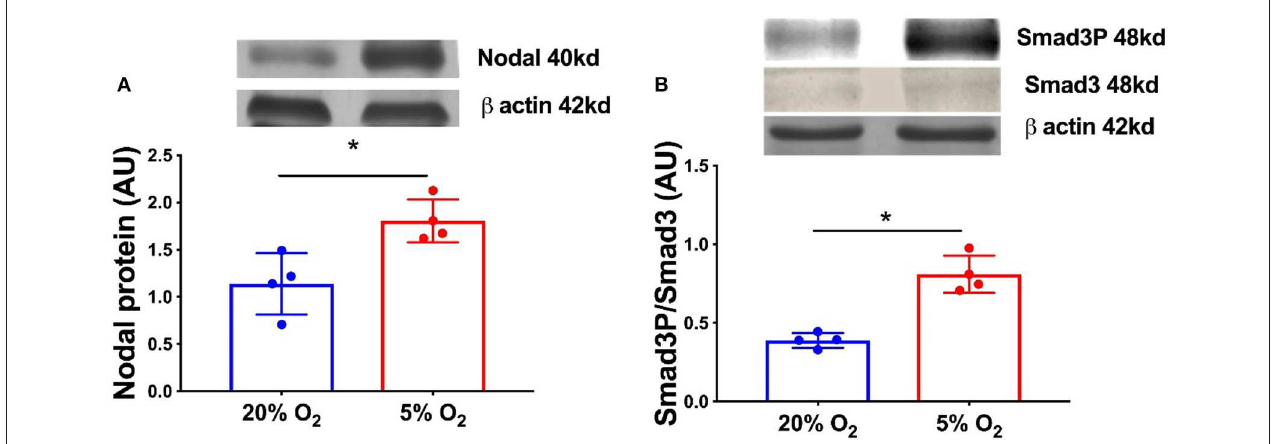
FIGURE 3 | Nodal signaling in mid CL explants cultured in vitro under hypoxia. Effect of hypoxia on (A) Nodal protein expression and (B) phosphorylation of Smad3 in mid CL explants cultured under 20% O 2 or 5% O 2 for 24h ( n = 4). Protein expression determined by western blot, upper panel: representative immunoblot; lower panel: densitometry of protein expression relative to β -actin expression. Values are expressed as means ± SEM in arbitrary units (AU). Statistical differences are marked with asterisks (* p < 0.05).